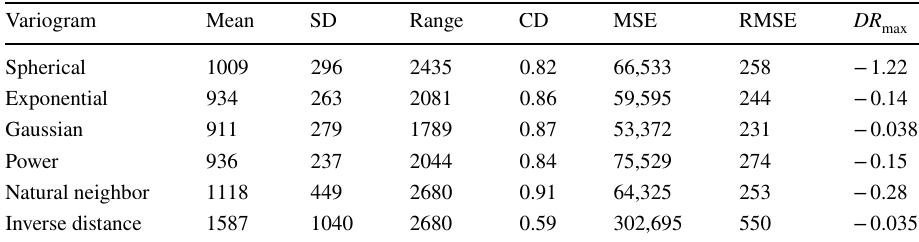
Fig. 6 Comparison between the estimated and observed TDS of different spatial